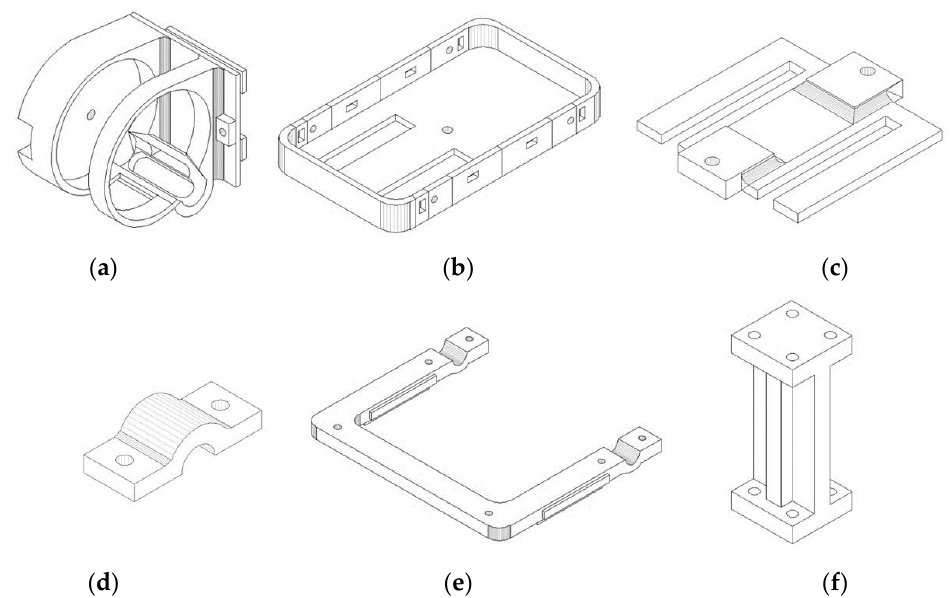
Figure 3. Component drawings of Parts A, B, C, D, E, and F. ( a ) Part A: LiDAR sensor support structure and cover; ( b ) Part B: Mini Computer, LiPo battery and connection cable support tray; ( c ) Part C: connection between tray and LiDAR sensor support structure; ( d ) Part D: UAV rail support anchor; ( e ) Part E: support handles; ( f ) Part F: GPS support structure. Table 2. 3D Printing Materials Comparison.